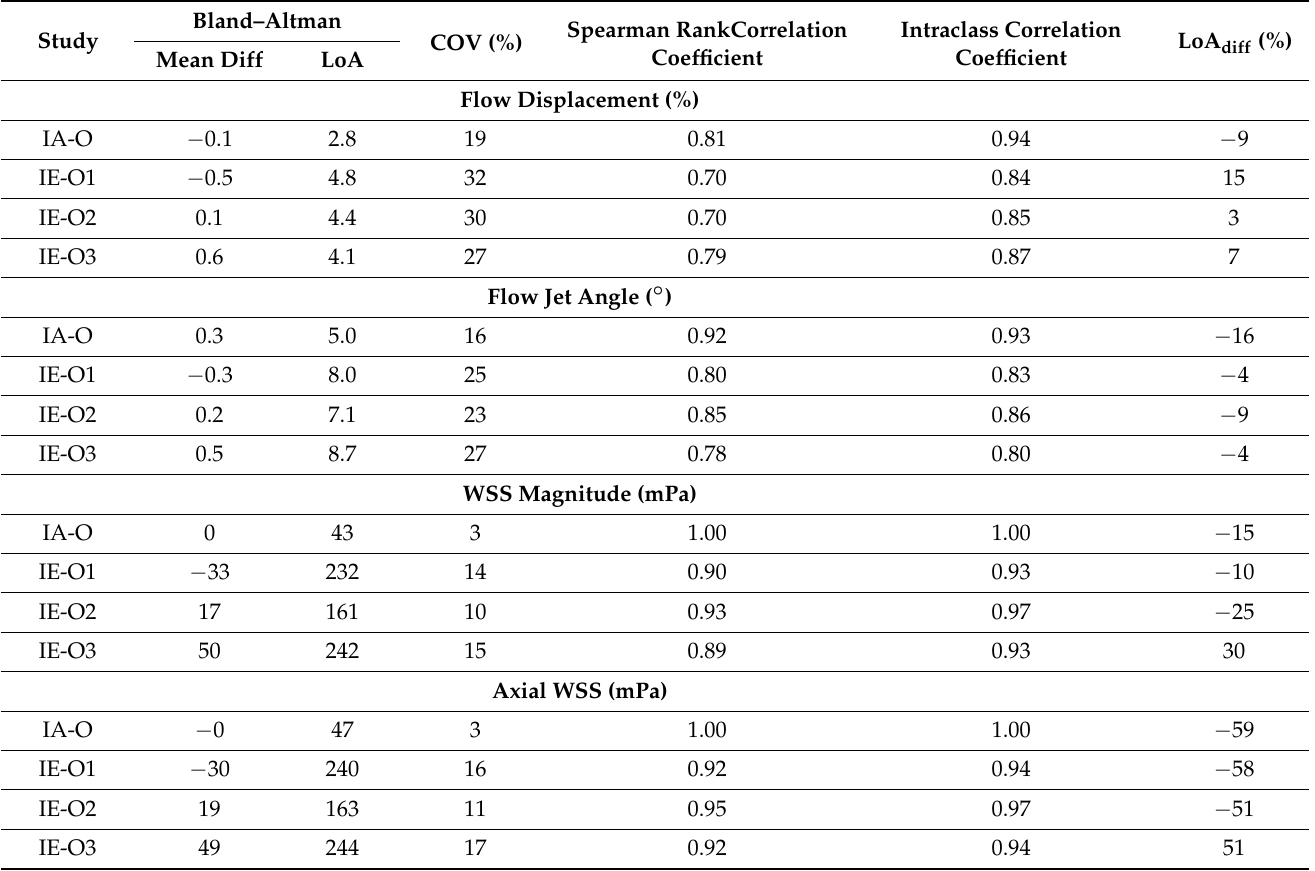
Table 3. Intra- and interobserver reproducibility: results of the validation